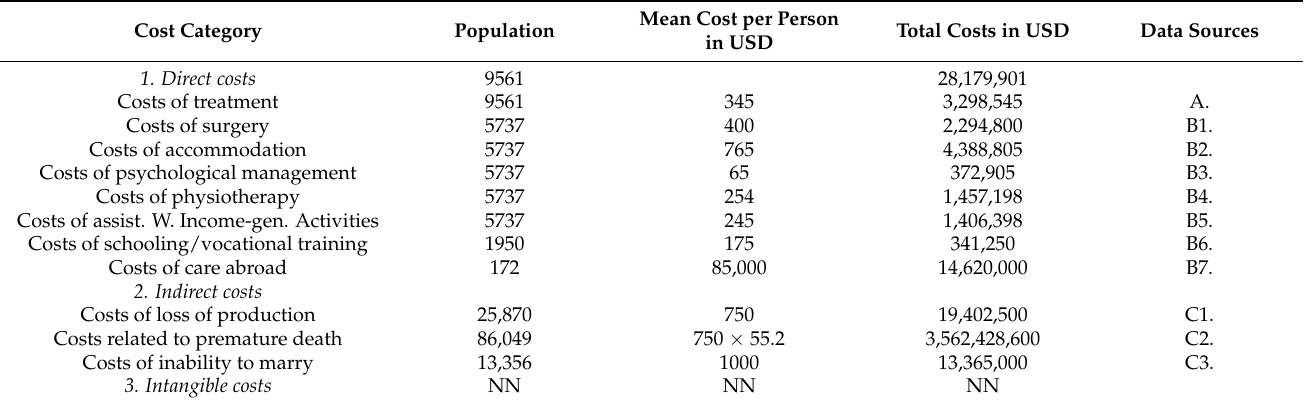
Table 4. Economic and social costs of noma in Burkina Faso in